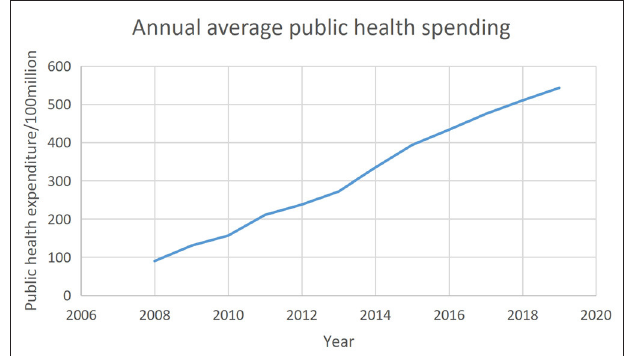
FIGURE 3 | Average annual public health spending in the period of 2008–2019.